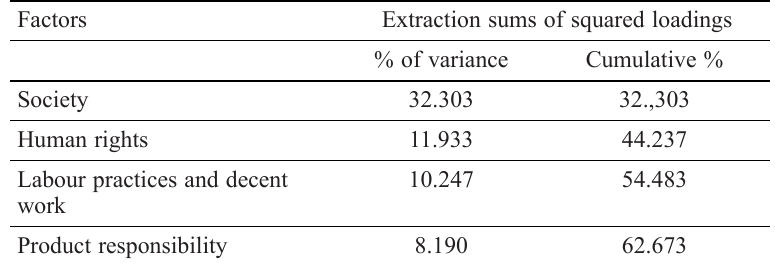
Table 3. Percent of explained variance by factors underling extension contents